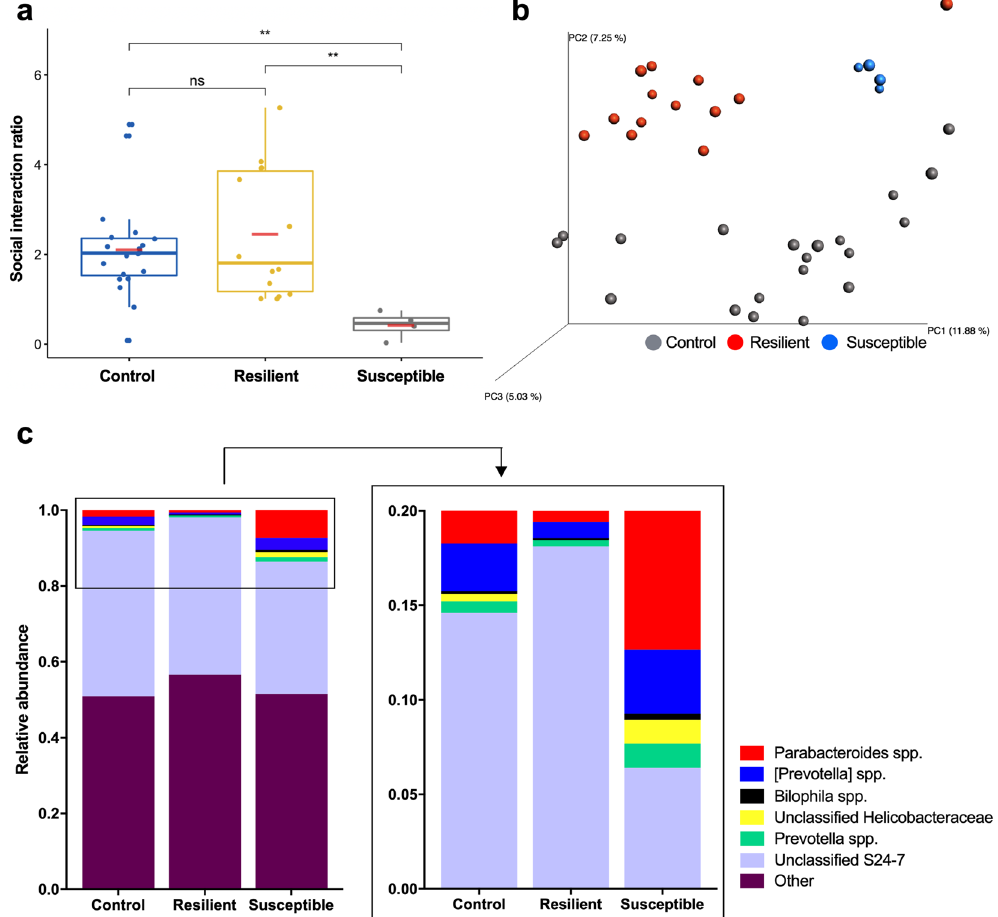
Figure 4. Exposure to chronic mild social defeat stress induces shifts in microbial communities and alters the abundance of relevant taxa. ( a ) Social interaction ratios (time in the interaction zone in the presence of a novel target mouse divided by time in this zone in the absence of a target mouse) of the non-stressed control, resilient, and susceptible mice. ( b ) Principal coordinate analysis of the microbiome community compositions in non-stressed control (n = 19), resilient (n = 14), and susceptible (n = 4) mice. ( c ) Taxonomic distribution at the genus level of fecal samples derived from the control and defeated groups. Susceptible mice displayed increases in Prevotella spp. (green) and an unclassified genus within the family Helicobacteraceae (yellow) relative to both control and resilient animals. Susceptible mice also revealed significant increases in Parabacteroides spp. (red) relative to resilient, but not control, animals.